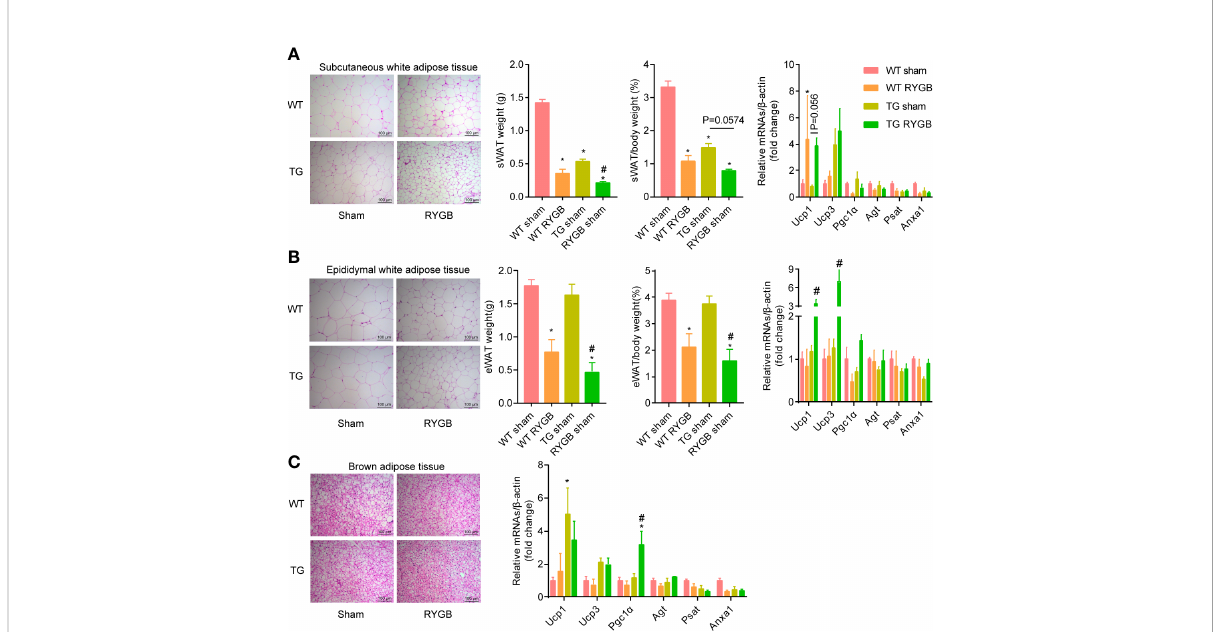
FIGURE 4 Effect of RYGB on white adipose tissue beigeing in TG mice with lower ghrelin levels Validated TG mice and wild-type littermates (WT) were fed with high fat diet (HFD) for 12 weeks before surgery and 3 weeks after surgery. Shown were histological (H&E) morphology, tissue weight, mRNA levels of brown-adipocyte marker genes ( Ucp1, Ucp3, Pgc1 a ) and white-adipocyte marker genes ( Agt, Psat, Anxa1 ) of sWAT (A) , eWAT (B) and BAT (C) of WT or TG mice. Results were expressed as mean ± SEM. P values were determined by one/two-way ANOVA, followed by